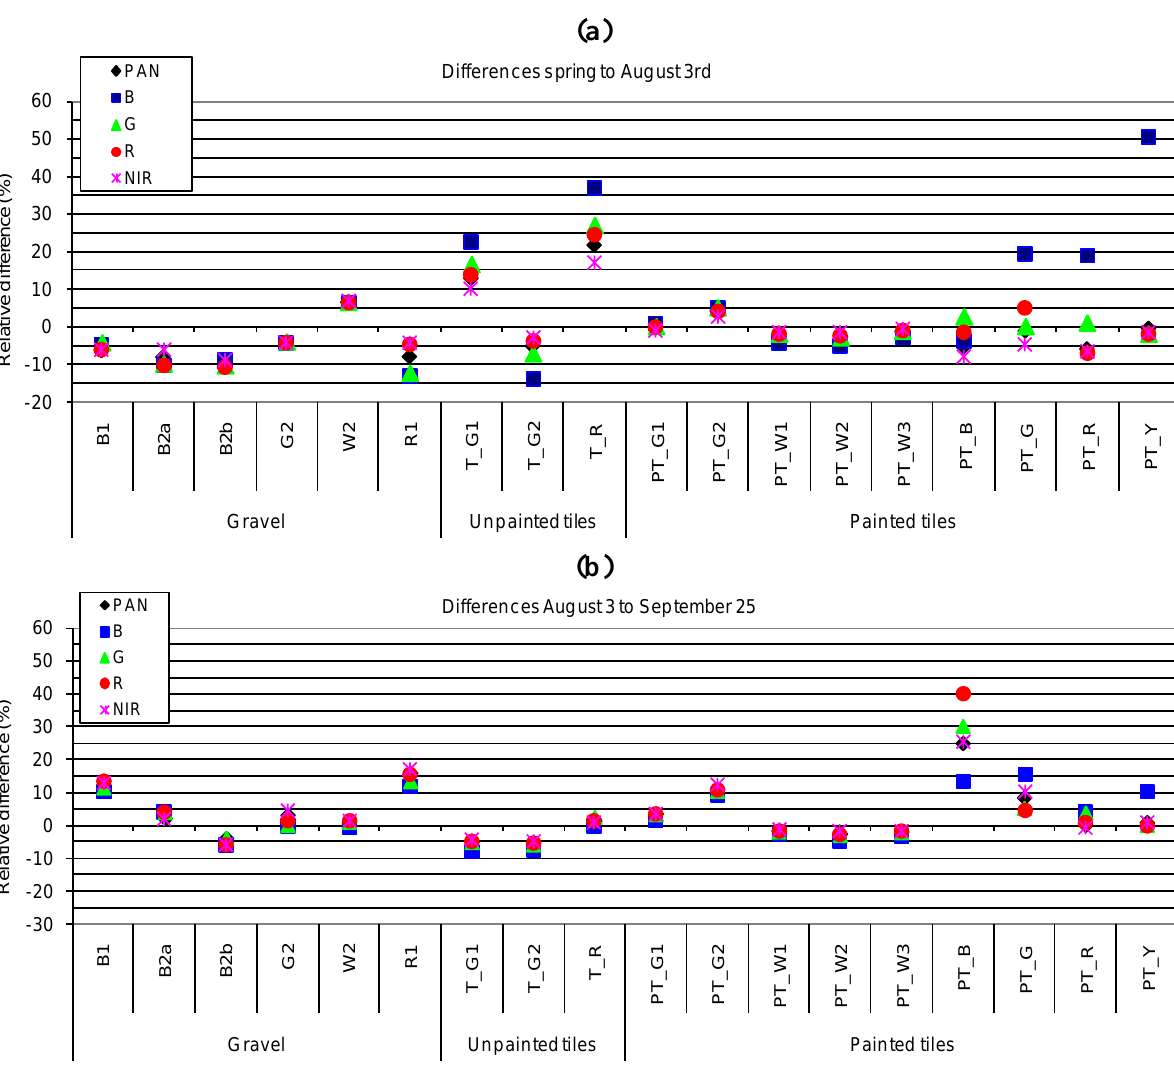
The changes on the different channels during the three-month period from May to August are shown in Figure 9a. The grey and black gravels and red gravel were getting darker and the white gravel was brightening. The changes were on the level of 5–10% for the grey, black and white gravels; for the red gravel the changes were different on different channels and rose up to 15%. For unpainted concrete tiles, the changes were larger at shorter wavelengths (the blue and green channel). One of the unpainted grey concrete tiles was darkening and another brightening during the period; the changes were up to 25% on the blue channel. The unpainted red tile got brighter during the period by 15–40%, depending on the wavelength. The changes to the painted grey and white concrete tiles were on the level of 5%; the white tiles were darkening and one of the grey tiles brightened slightly. For the painted color tiles, the changes were different on different channels; on the red, green and NIR channels the changes were −10% to 5% and on the blue channel up to 50% (the largest changes occurred on the yellow